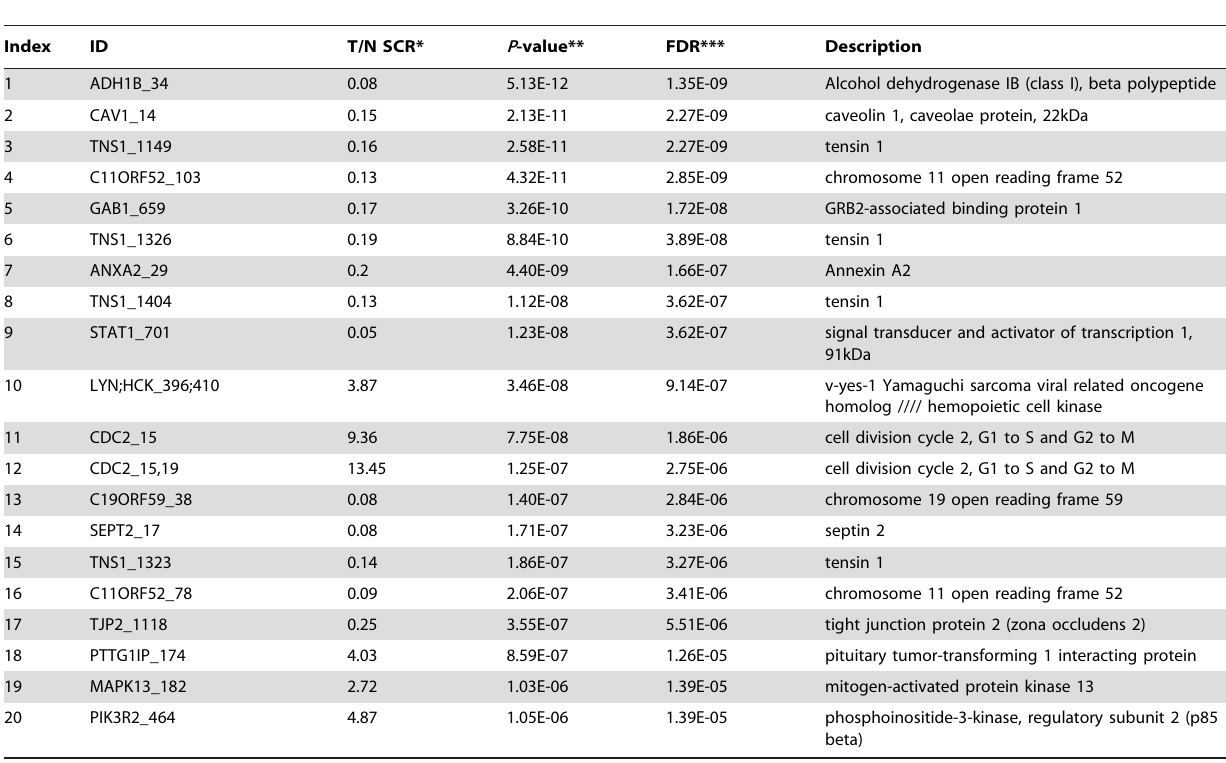
* T/N SCR: Tumor/normal phosphorylation spectral count ratio; ** P-value: significance of difference between two sample groups with rank sum test; *** FDR: False discovery rate correction of the p values. doi:10.1371/journal.pone.0007994.t001 PLoS ONE |